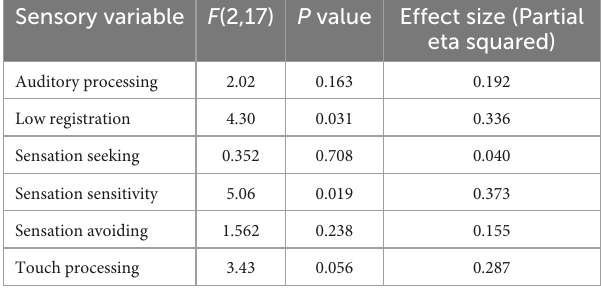
TABLE 3 Univariate results for sensory clinical data by cluster